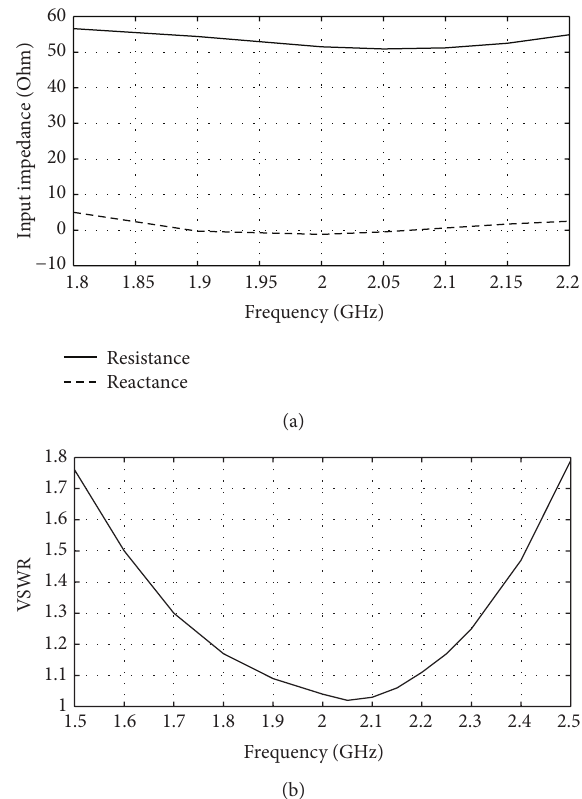
Figure 11: Variation of (a) the input impedance and (b) VSWR of a split coaxial balun terminated by a balanced 140 Ω -load with the = 8 mm, 𝐷 = 3.5 mm, 𝐷 frequency; 𝐷 1 in out = 3.44 cm, 𝐿 = 6.34 cm, 𝐿 6.72 cm, 𝐿 2 out 1 in = 50 ∘ . 3.8 mm, and 𝜃 𝑠